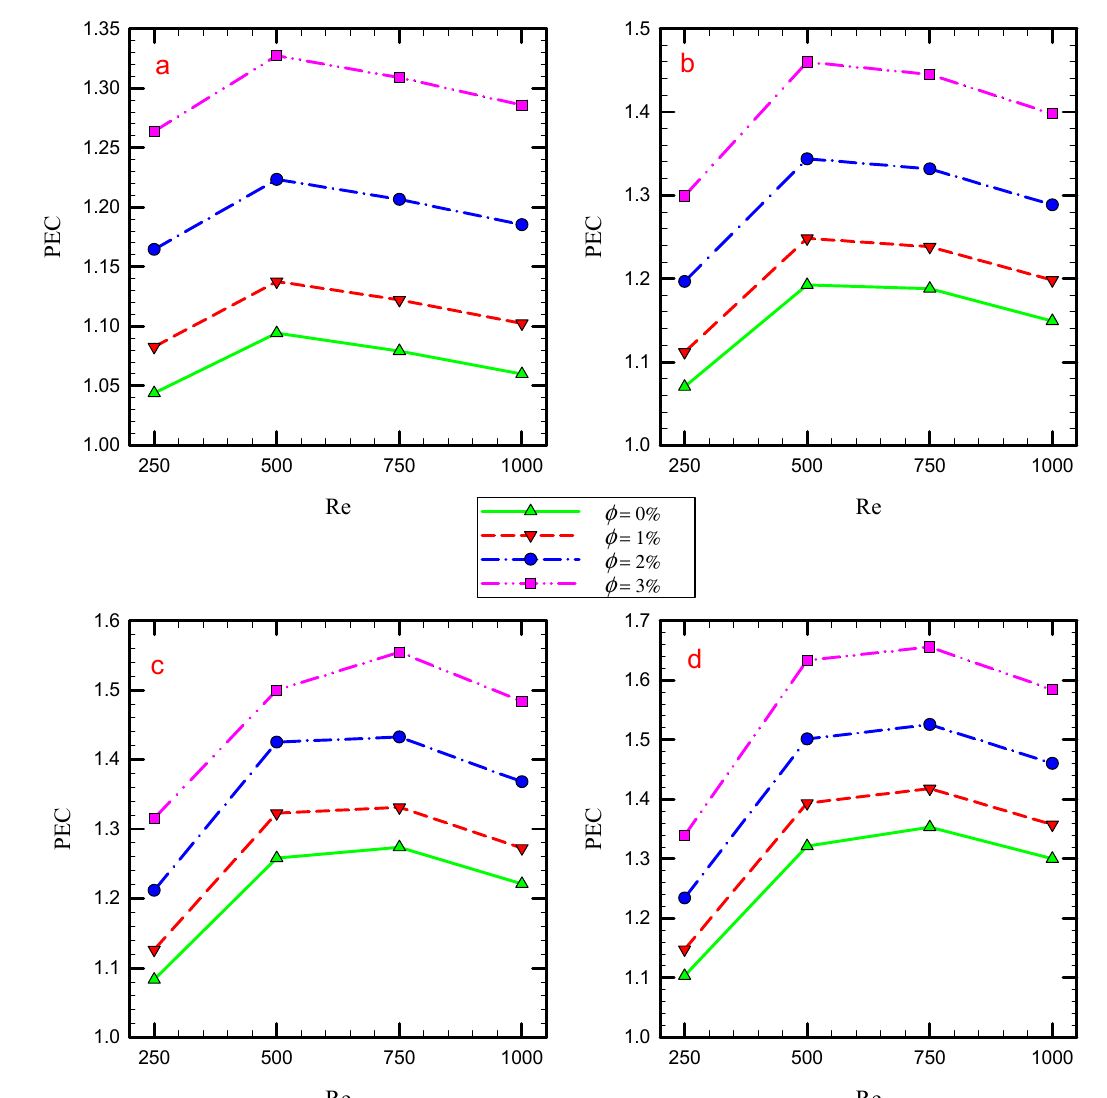
Figure 20. The relation between the PEC and Re at different nanoparticles concentration for Cases ( a ) 2, ( b ) 3, ( c ) 4, and ( d ) 5.